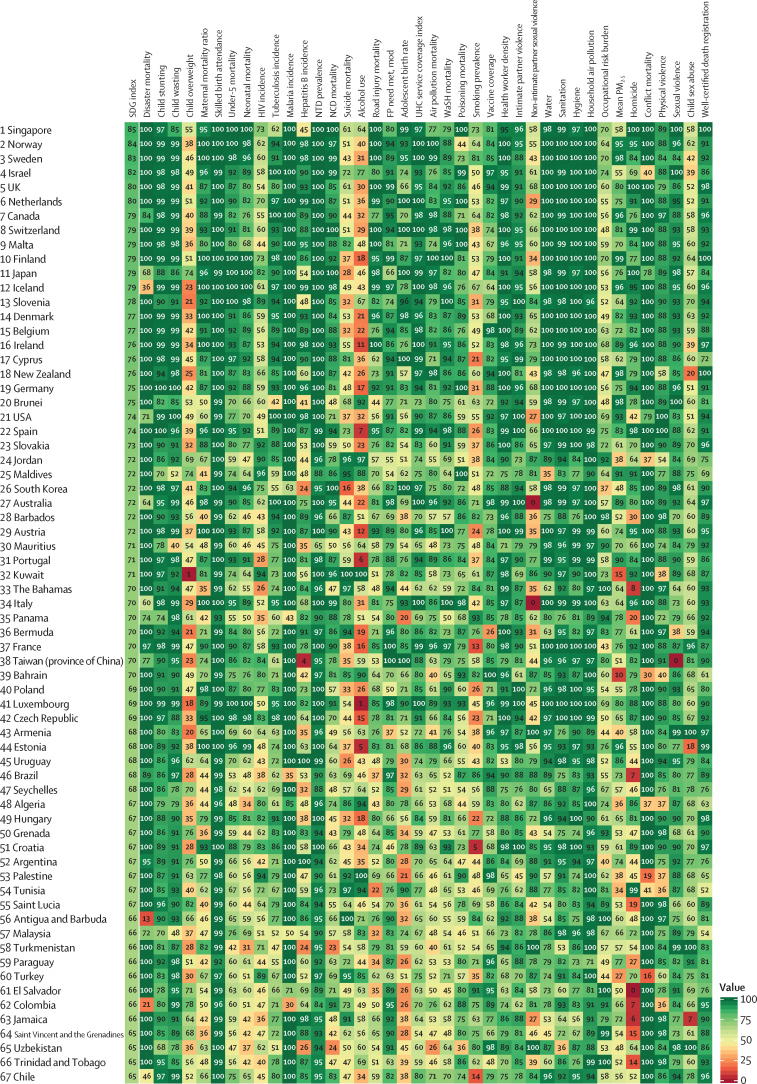
Performance on the health-related SDG index and 40 individual health-related indicators, by location, in 2017Countries and territories are ranked by their health-related SDG index from highest to lowest in 2017. Indices and individual indicators are reported on a scale of 0 to 100, with 0 representing the worst scores from 1990 to 2030 and 100 reflecting the best during that time. SDG indicator 17.19.2a, population census status within the past 10 years, was not included in the health-related SDG index because projections were not generated for this indicator. Definitions of health-related SDG indicators are shown in table 1. FP need met, mod=family planning need met with modern contraception methods. NCD=non-communicable disease. NTD=neglected tropical disease. PM2·5=fine particulate matter smaller than 2·5 μm. SDG=Sustainable Development Goal. UHC=universal health coverage. WaSH=water, sanitation, and hygiene.